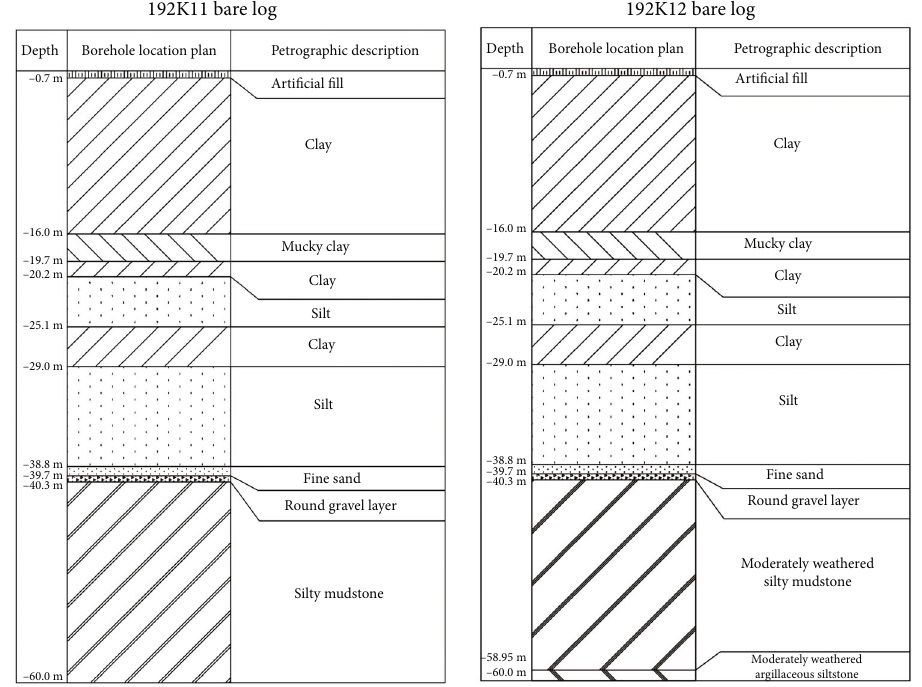
Figure 2: General situation of strata in the study